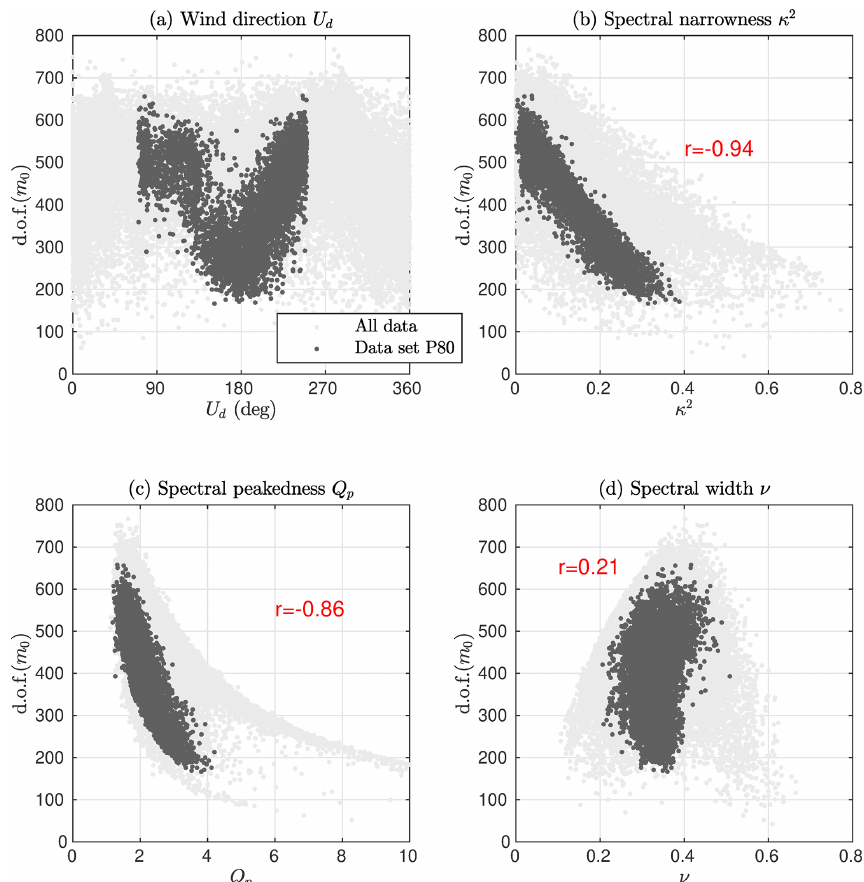
Figure 5. The degrees of freedom of the Suomenlinna (T2) wave variance as a function of the wind direction (a) and the different spectral width and narrowness parameters (b–d)